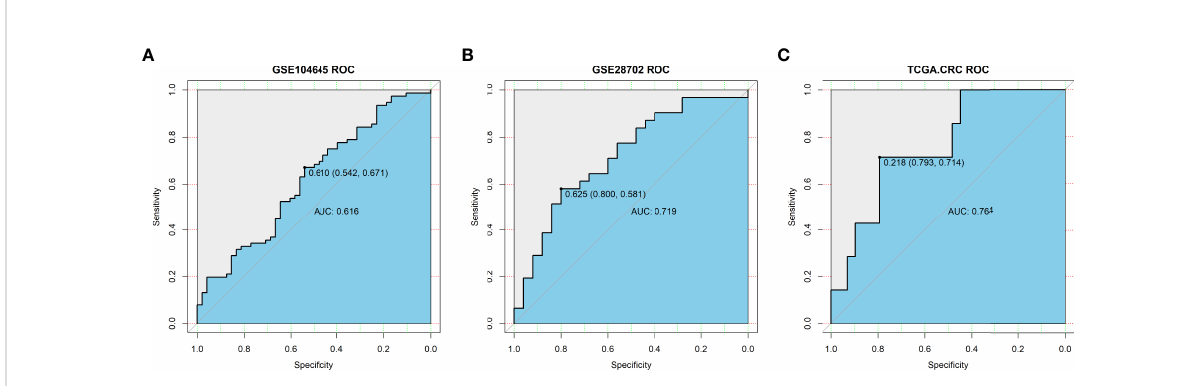
FIGURE 6 Validation of predictive value of TMEscore-relate genes signature in the response to chemotherapy in (A) GSE104645 dataset; (B) GSE28702 dataset; (C) TCGA-COADREAD dataset (36 patients underwent 5- Fluorouracil